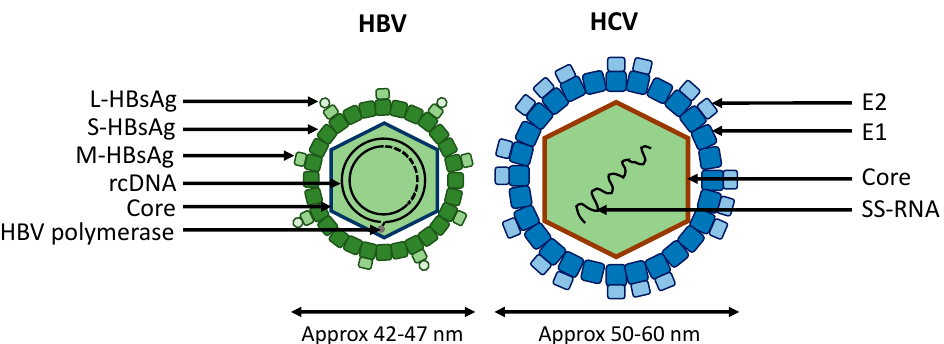
Figure 1. Comparison of hepatitis B virus (HBV) and hepatitis C virus (HCV) viral structures. The HCV virion is larger than the HBV virion by approximately 20 nm. HBV and HCV are two hepatotropic viruses which use di ff erent receptors for viral entry. Three di ff erent Hepatitis B surface antigens are exposed on HBV particles: the small (S-HBsAg), the medium (M-HBsAg) and the large (L-HBsAg) surface antigens. The HBV nucleocapsid is formed by dimers of hepatitis B core proteins (HBcAg) and contains a partly double-stranded DNA genome in relaxed conformation (3.2 kb in length). The HCV virion exposes two di ff erent viral envelope proteins on its surface: E1 and E2. HCV capsid is formed by HCV core proteins which contains a positive single-stranded RNA (9.6 kb in length). HBV = Hepatitis B virus; HCV = Hepatitis C virus; rcDNA = relaxed circular DNA; cccDNA = covalently closed circular DNA; SS-RNA = single stranded RNA.